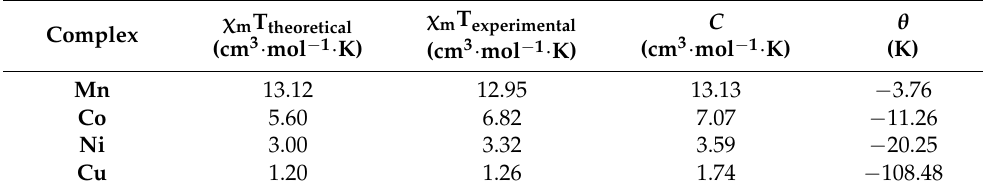
Table 1. Comparison of theoretical and experimental χ m T product and Curie–Weiss parameters ( C and θ ) for all the complexes.